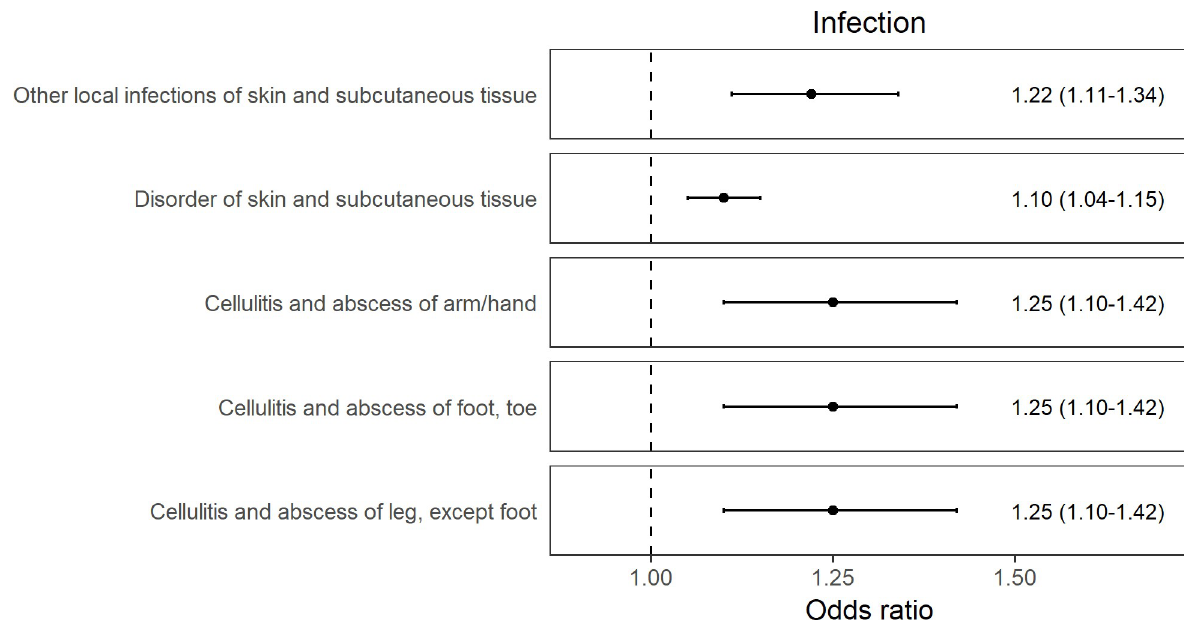
Fig 3. Forest plot of results for traits related to skin and skin structure infections for which there was evidence across the 3 genetic instruments for a causal effect of higher iron status. The ORs are reported as MR estimates corresponding to 1 SD increase in serum iron. MR, mendelian randomization; OR, odds ratio; SD, standard